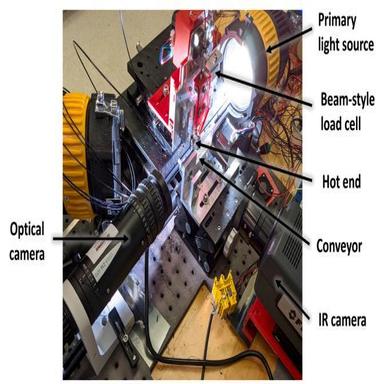
The measurement system.